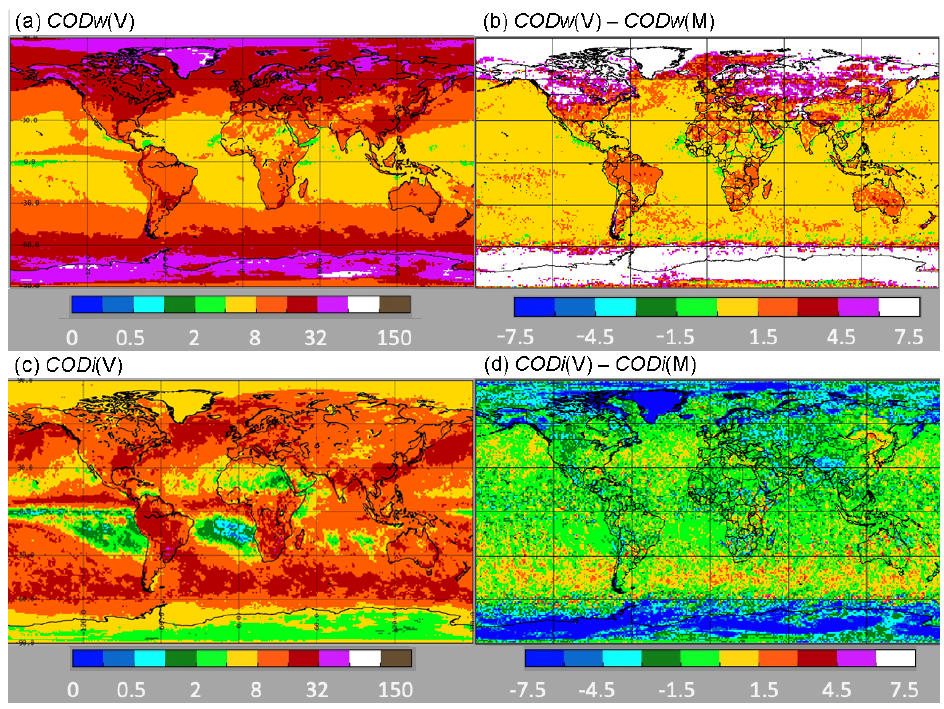
Figure 10. Mean 2013 daytime cloud ( a ) CV1S liquid cloud optical depth and ( b ) difference in the optical depth, CODw (V) − CODw (M), for liquid clouds, ( c ) CV1S ice cloud optical depth and ( d ) difference in the optical depth for ice